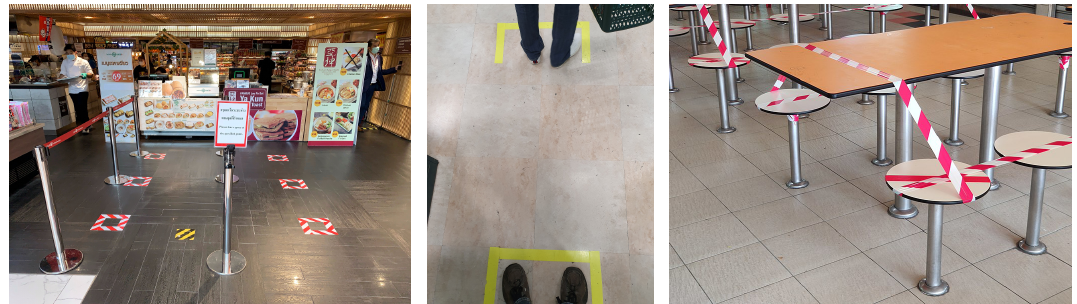
Figure 1. Visual markings placed to assist in the maintaining of physical distance. Source: Wikimedia commons. Markings come in very different shapes and cannot be perceived by blind or visually impaired people.